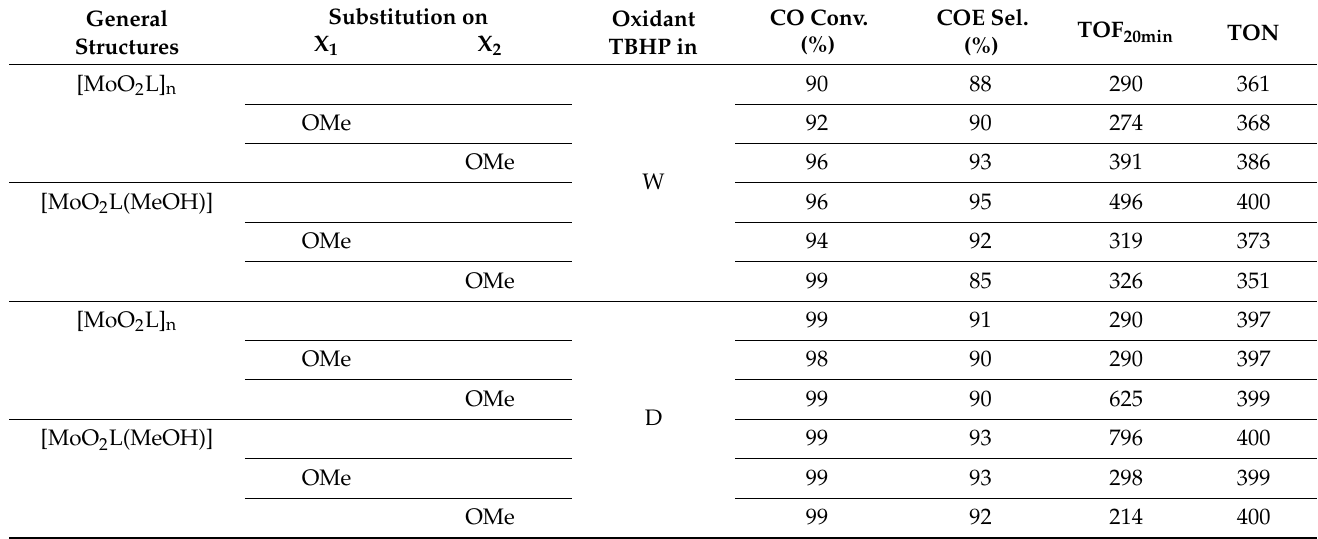
Figure 10. Schematic representation of neutral oligomeric and polymeric species studied containing the hydrazonato ligand. Table 7. Results of CO epoxidation and selectivity toward COE under organic solvent free conditions with MoO 2 L complexes of Figure 10.